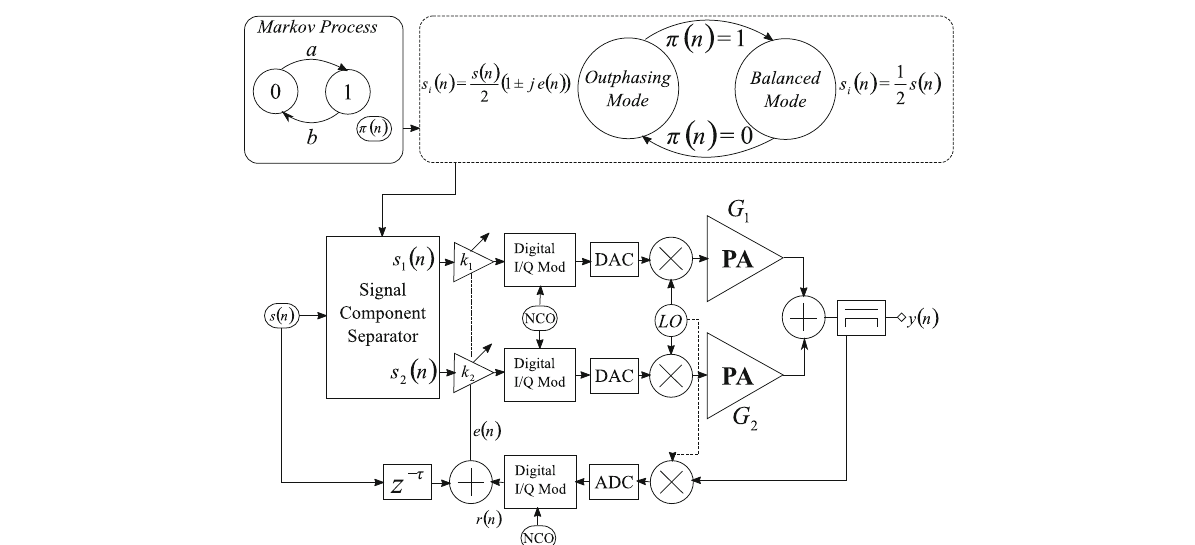
Fig. 2 Proposed Markov-multiplexed LINC architecture. The switching is controlled by a sequence which can be real-time generated or stored in a ROM using a state